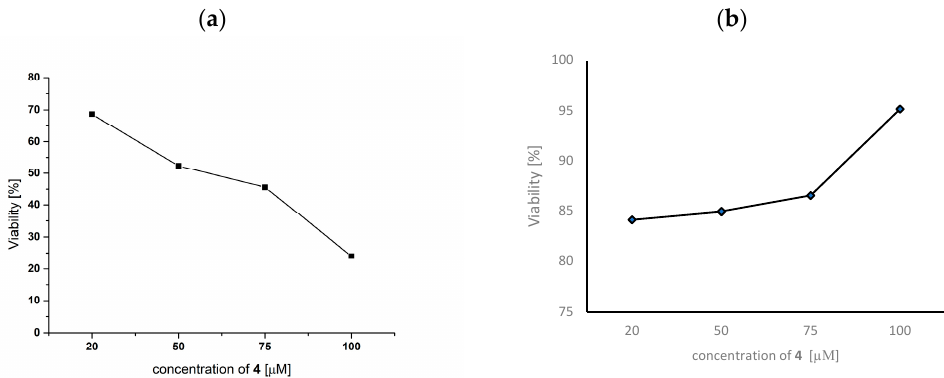
Figure 13. Cell proliferation of ( a ) MCF-7 cancer cells and ( b ) MRC-5 healthy cells in response to 4 after 72 h of exposure. Cell lines were treated (20–100 µ mol/L) with complex 4 , and viable cells were evaluated using a colorimetric assay.